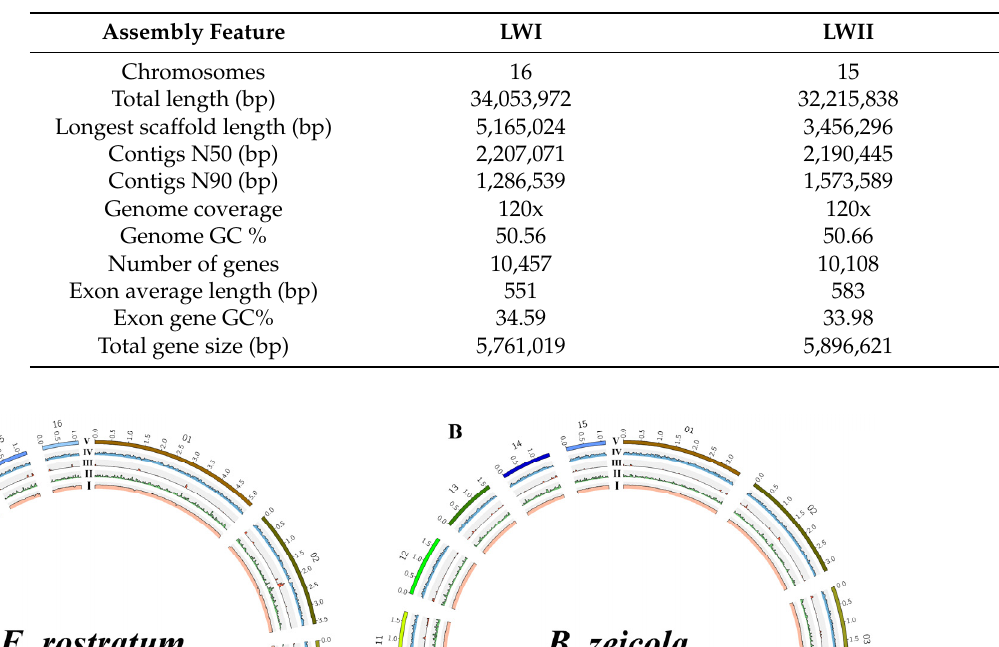
Table 1. Genomic features of E. rostratum LWI and B. zeicola LWII.